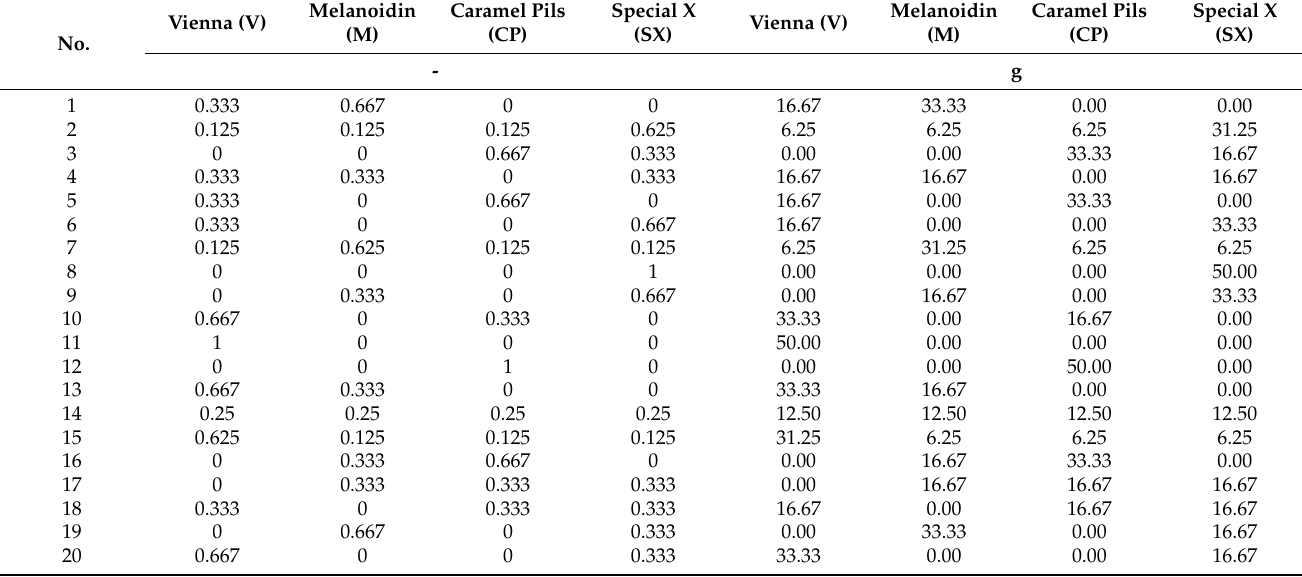
Table 1. The content of Vienna, Melanoidin, Caramel pils, and Special X malts in different malt mixtures in codded and real